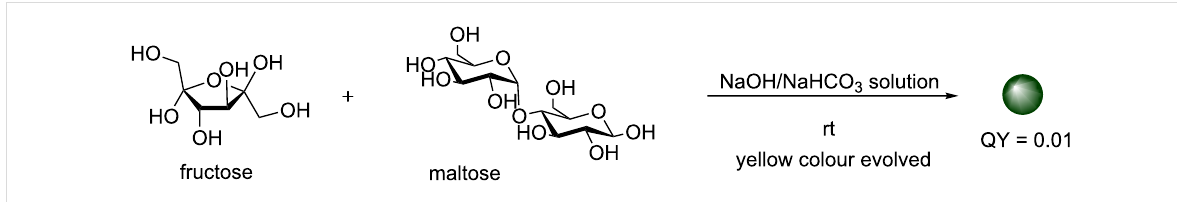
Scheme 14: Base-mediated synthesis of CDs with nanocrystalline cores, from fructose and maltose, without forcing reaction